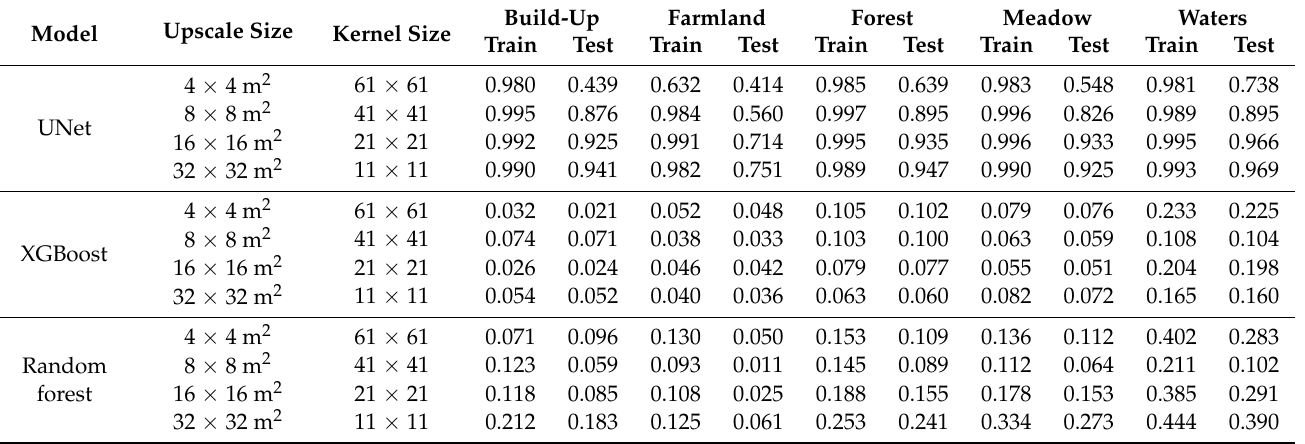
Table 1. Performance (R 2 ) of local surface complexity UNet models with varying upscales and kernel sizes.